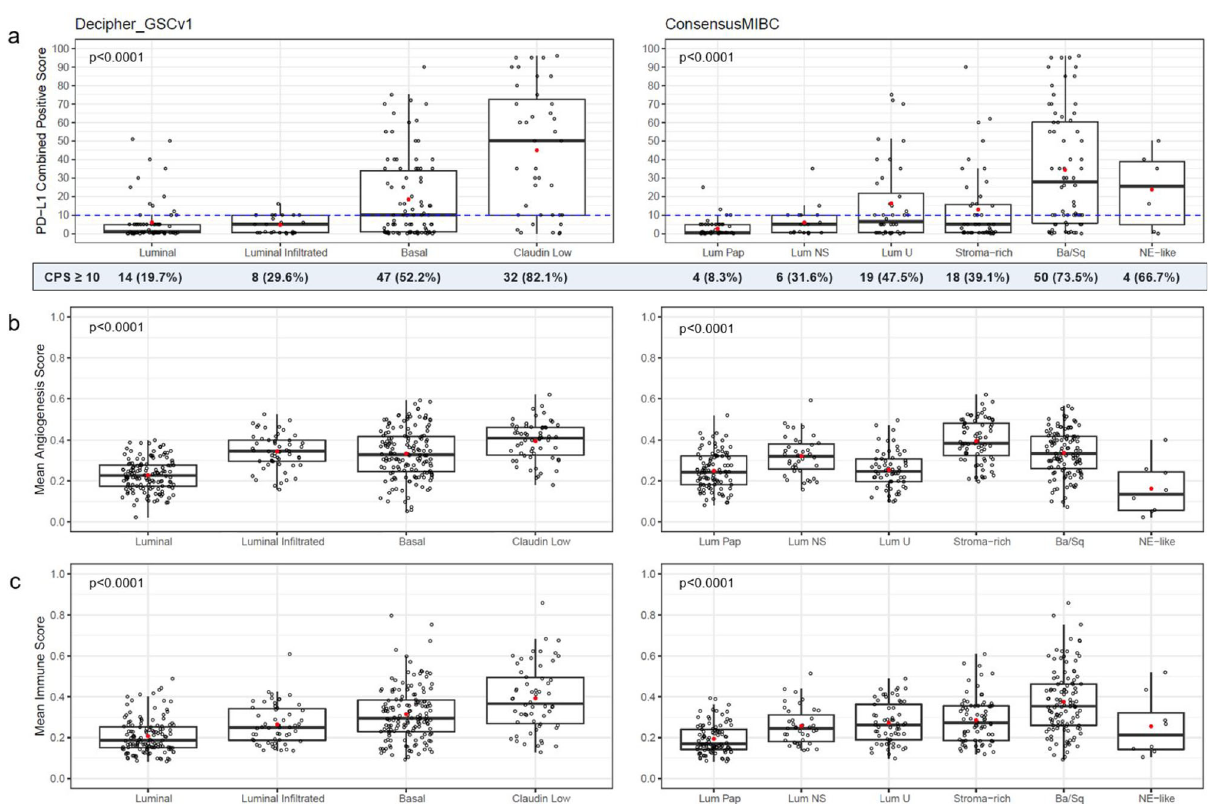
Fig. 3 Molecular subtype association with PD-L1 CPS and mean angiogenesis/immune signature scores. a Association of PD-L1 expression by CPS with molecular subtypes as de fi ned by the Decipher GSCv1 and ConsensusMIBC classi fi cation schemes in the TR1 population ( n = 227 samples from n = 227 participants in the TR1 population). For boxplots, the center line represents median, box hinges represent fi rst and third quartiles, whiskers represent minimum and maximum within 1.5x interquartile range, and red marker is mean. Decipher GSCv1 F-test, p < 0.0001; ConsensusMIBC F-test, p < 0.0001. p -values indicated are for one-way ANOVA, without multiplicity adjustment. The blue dotted line indicates CPS ≥ 10 cutoff. Number and percent of patients with CPS ≥ 10 for each tumor subtype indicated below the plot. b Mean of angiogenesis signature scores relative to molecular subtypes of the Decipher GSCv1 and ConsensusMIBC classi fi cation schemes in the TR2 population ( n = 394 samples from n = 394 participants in the TR2 population). Decipher GSCv1 F-test, p < 0.0001; ConsensusMIBC F-test, p < 0.0001, without multiplicity adjustment. p -values indicated are for one-way ANOVA. c Mean of immune signature scores relative to molecular subtypes of the Decipher GSCv1 and ConsensusMIBC classi fi cation schemes in the TR2 population ( n = 394 samples from n = 394 participants in the TR2 population). Decipher GSCv1 F-test, p < 0.0001; ConsensusMIBC F-test, p < 0.0001. p -values indicated are for one-way ANOVA, without multiplicity adjustment. For boxplots, the center line represents median, box hinges represent fi rst and third quartiles, whiskers represent minimum and maximum within 1.5x interquartile range, and red marker is mean. Decipher GSCv1 subtype prevalence ( n / group): Luminal ( n = 131), Luminal In fi ltrated ( n = 55), Basal ( n = 150), Claudin Low ( n = 58). ConsensusMIBC subtype prevalence ( n /group): Luminal Papillary ( n = 97), Luminal Non-Speci fi ed ( n = 39), Luminal Unstable ( n = 61), Stroma-rich ( n = 75), Basal/Squamous ( n = 114), Neuroendocrine-like ( n = 8). Source data are provided as a Source Data fi le. Ba/Sq, Basal/Squamous; CPS, combined positive score; Lum NS, Luminal Non-Speci fi ed; Lum Pap, Luminal Papillary; Lum U, Luminal Unstable; NE-like, Neuroendocrine-like; PD-L1, programmed cell death ligand